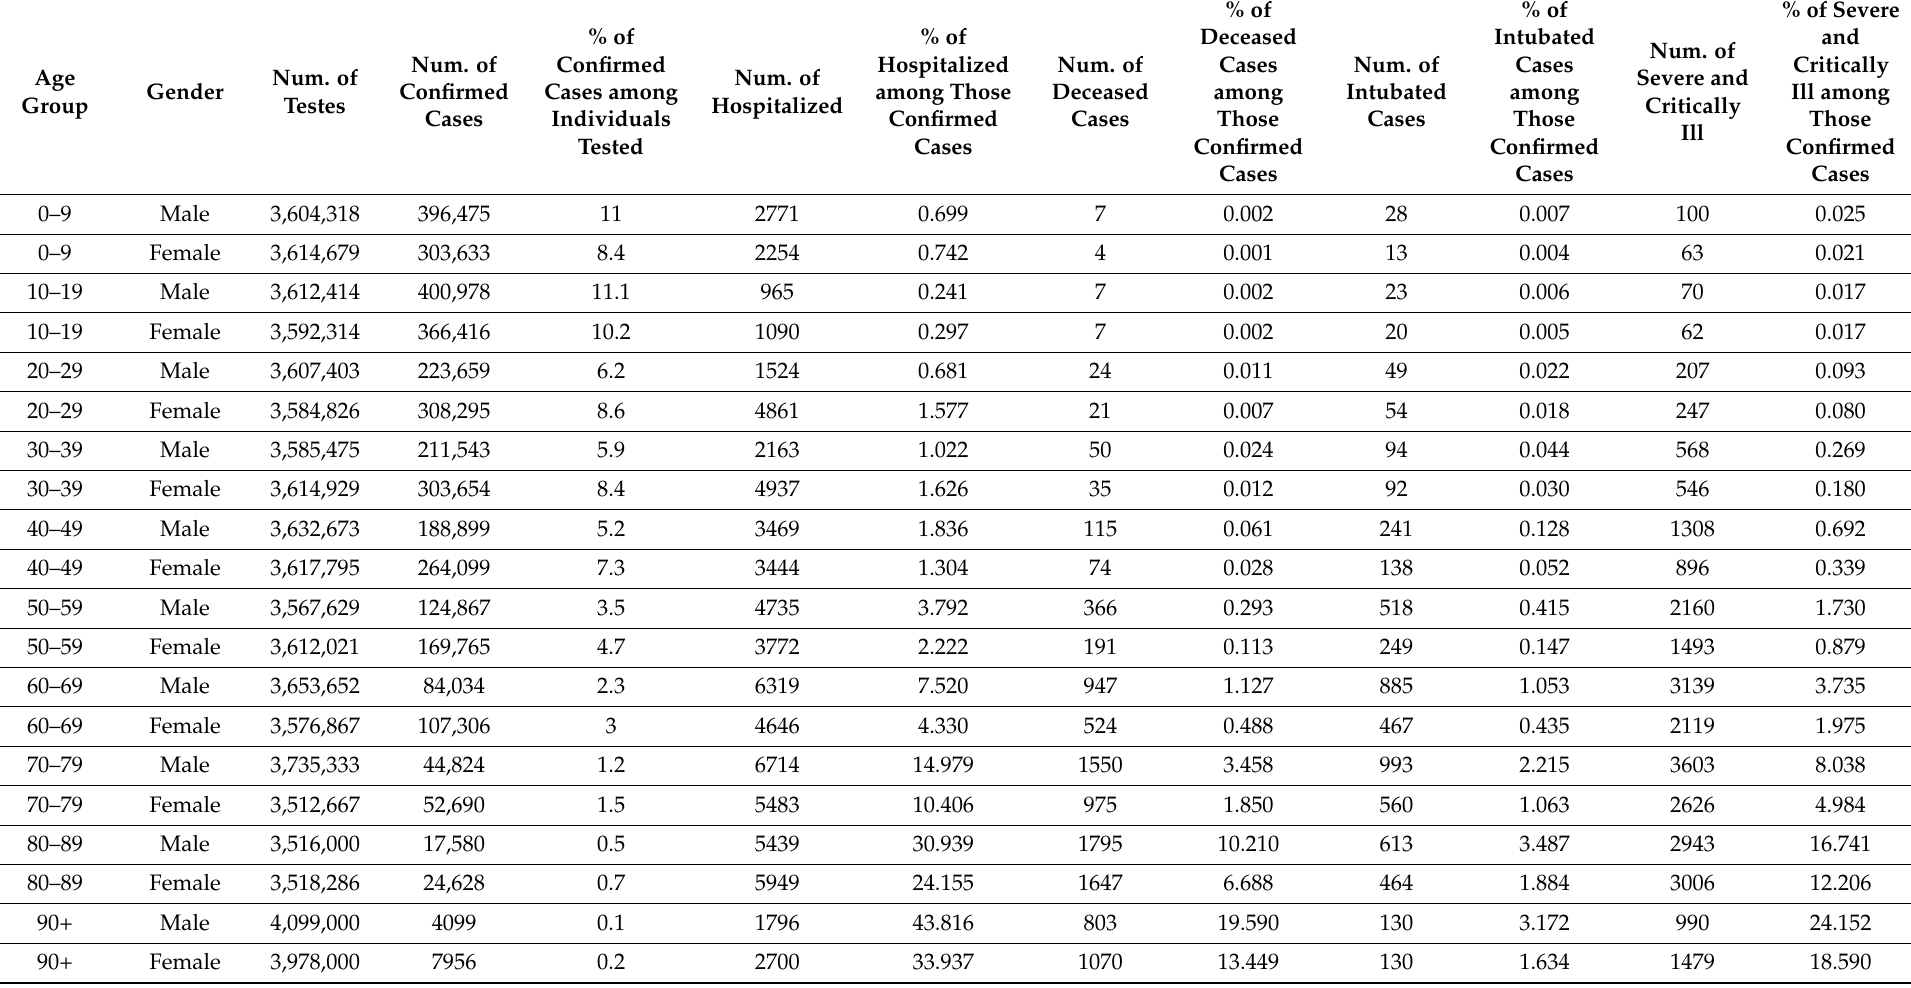
Table 1. Descriptive statistics of COVID-19 cases from 1 March 20 until 1 March 22, (n =